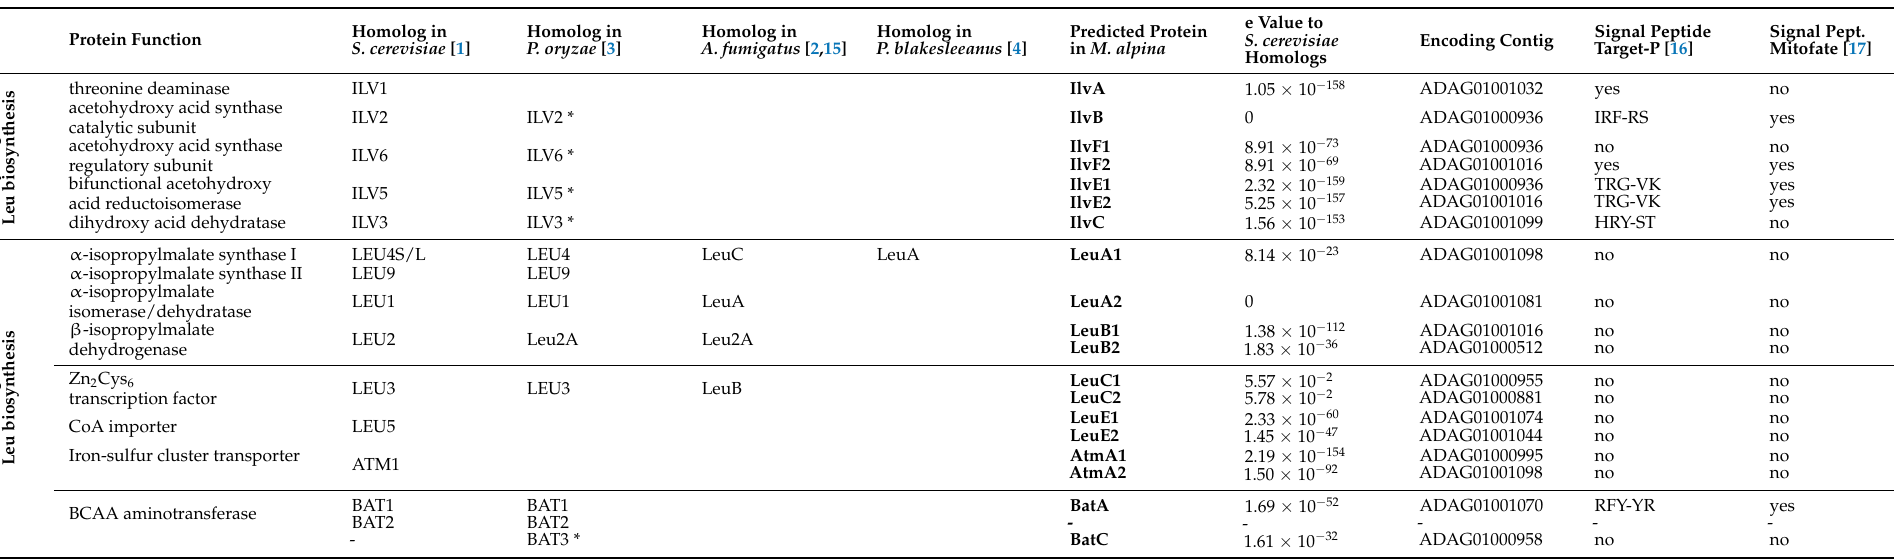
Table 1. Proteins of Leu metabolism in M. alpina . Proteins with verified function ( Saccharomyces cerevisiae , Pyricularia oryzae , Aspergillus fumigatus , Phycomyces blakesleeanus ) are shown. *, predicted function. +, BlastP analysis according to Bat3 from P. oryzae [3]. e Value to Homolog in Homolog in Homolog in Homolog in Predicted Protein S. cerevisiae Encoding Contig Signal Peptide Target-P [16] Signal Pept. Mitofate S. cerevisiae [1] P. oryzae [3] A. fumigatus [2,15] P. blakesleeanus [4] in M. alpina Homologs